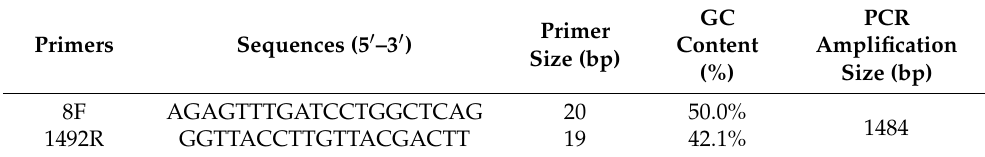
Table 1. Primer sequence used for PCR amplification.